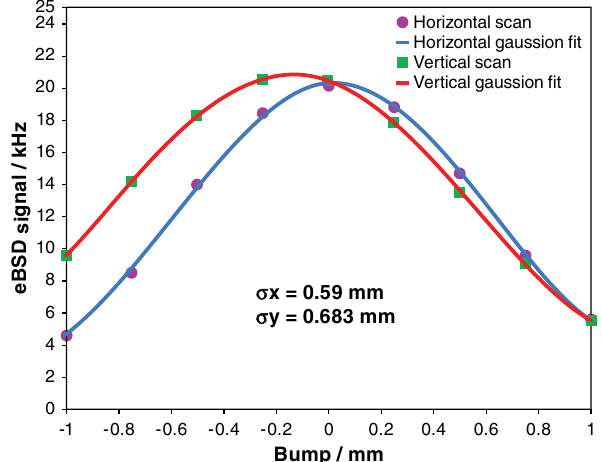
FIG. 11. Manual beam separation scans obtained by stepwise steering the 3 He beam with closed bumps utilizing part of the algorithm developed for the automated alignment optimization system based on the LISA program [28].